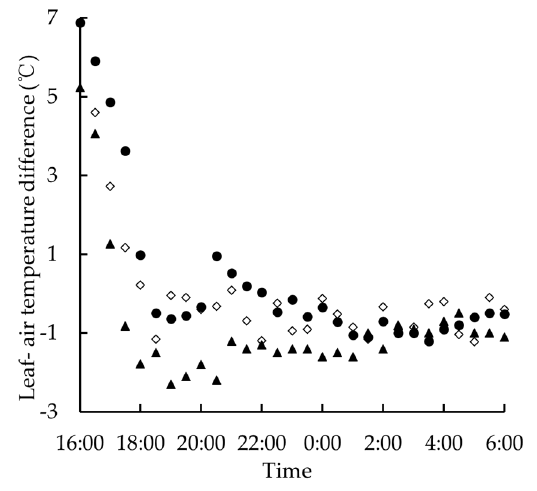
) is represented for the dates of